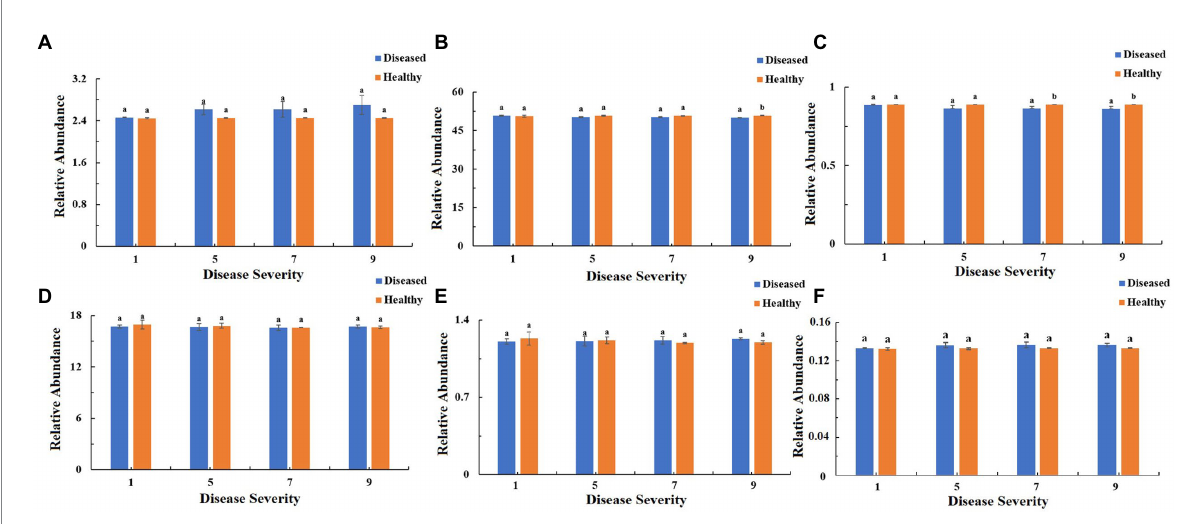
FIGURE 10 PICRUSt analyses of the changes in the KEGG level 1 functional categories of bacteria in tobacco leaf samples. (A) Cellular Processes, (B) Metabolism, (C) Organismal Systems, (D) Genetic Information Processing, (E) Human Diseases, (F) Environmental Information Processing.